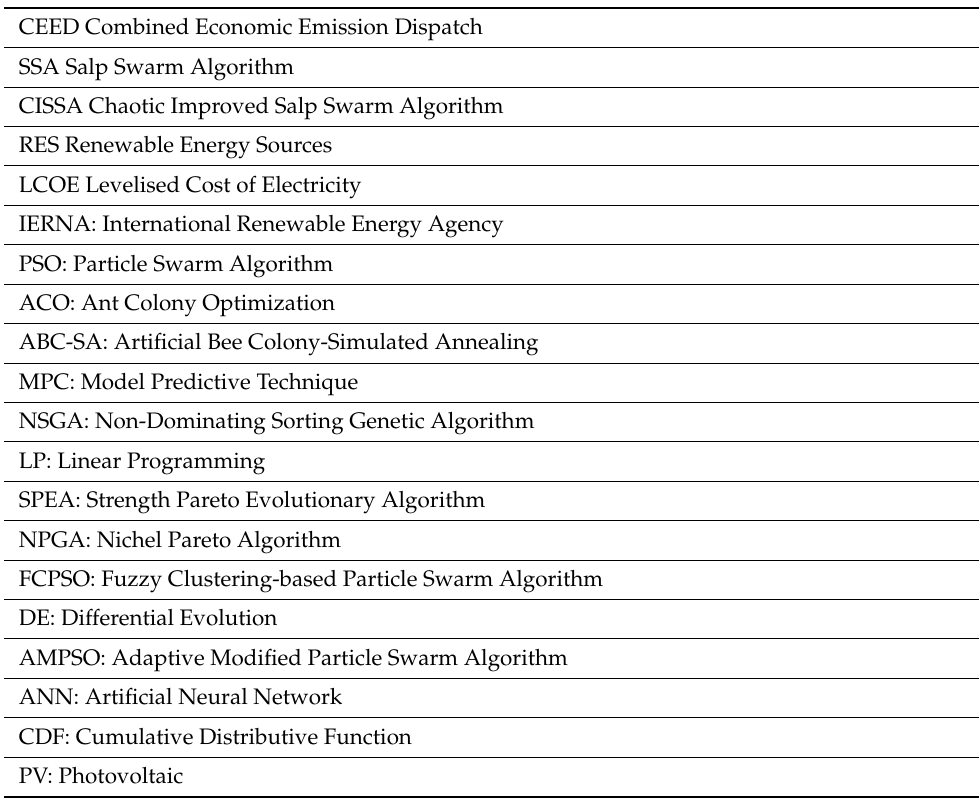
Table 1. List of